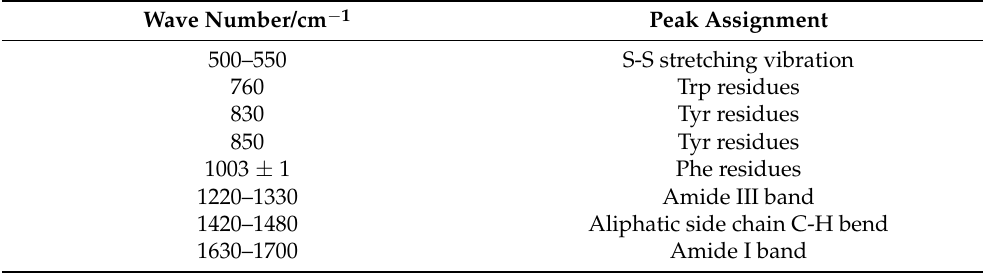
Figure 2. RB-SPI plants simulated meat Raman spectra with different RB contents. Table 2. Assignment of bands in the Raman spectrum of RB-SPI plant-based simulated meat.